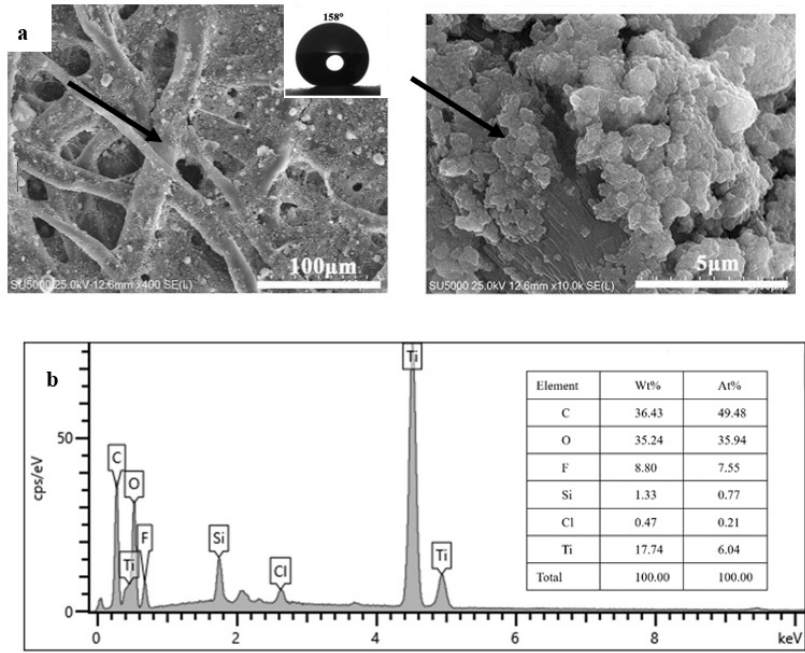
Figure 4. SEM images of the modified filter paper at different magnitude, inlet is the CA photo ( a ); EDS analysis of the modified filter paper ( b ).